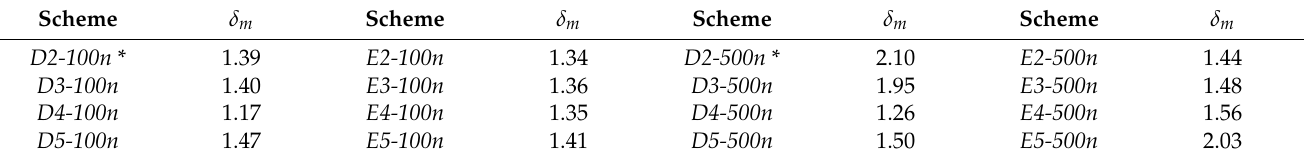
Figure 6. Measured SEY curves as a function of primary electron energy before and after the etching and gold coating. The red shadow area with dotted line in it represents the error from multiple measurements. Table 3. The δ m values of the substrates treated with different schemes of process parameters.